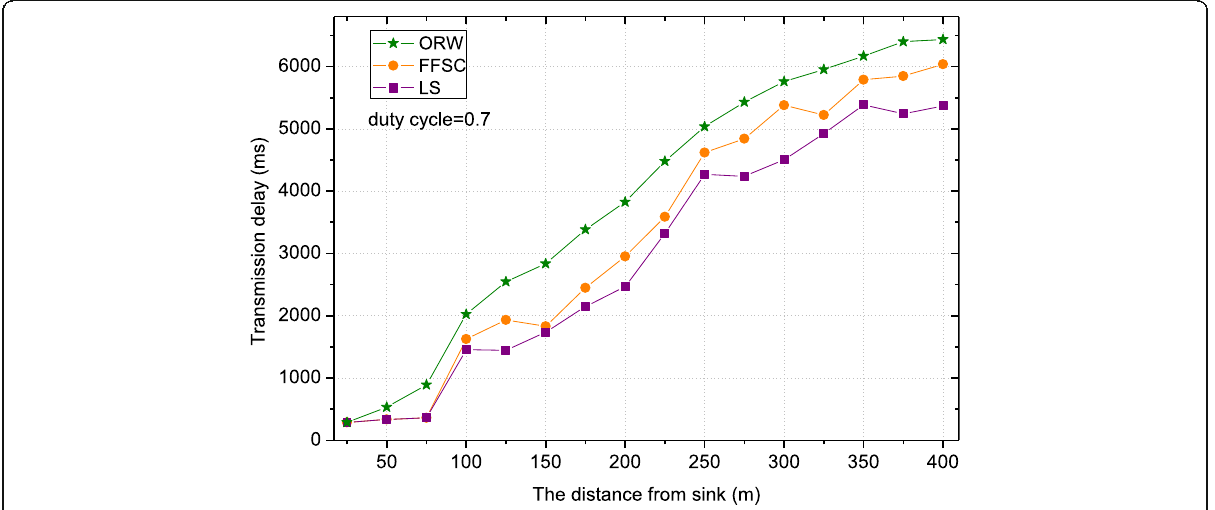
Fig. 19 The total delay under different distance from